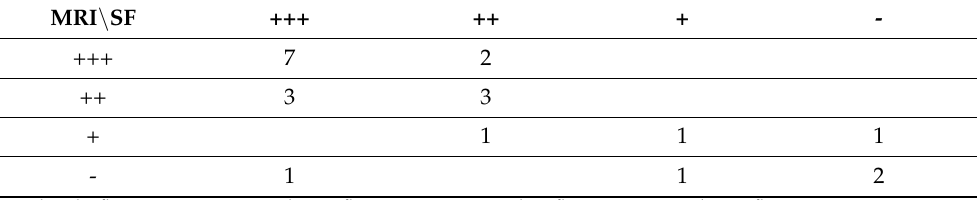
Table 3. Preoperative MRI gadolinium enhancement intensity and degree of intraoperative fluorescence. MRI \